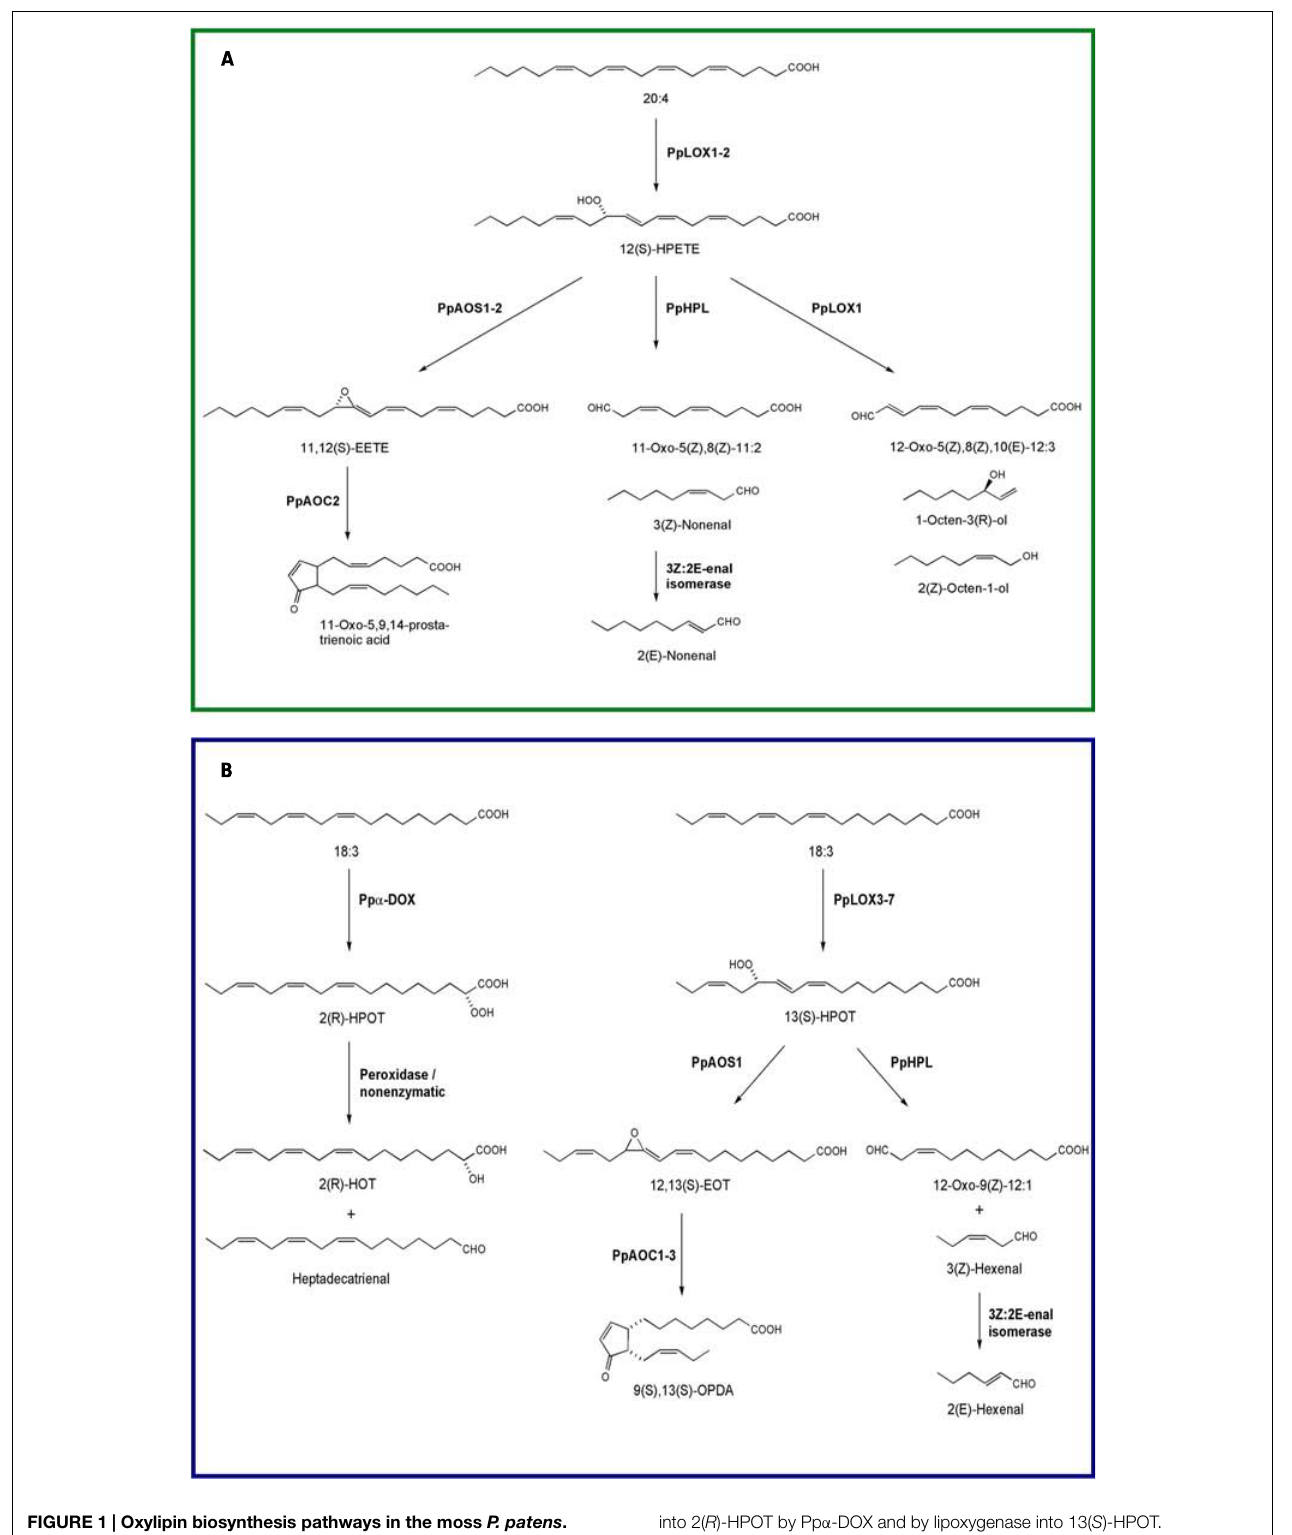
FIGURE 1 | Oxylipin biosynthesis pathways in the moss P. patens . (A) Lipoxygenase-catalyzed oxygenation of arachidonic acid into 12( S )-HPETE and further conversions of this hydroperoxide by allene oxide synthase (PpAOS1-2), allene oxide cyclase (PpAOC2), hydroperoxide lyase (PpHPL), and 12-lipoxygenase (PpLOX1). (B) Oxygenation of linolenic acid